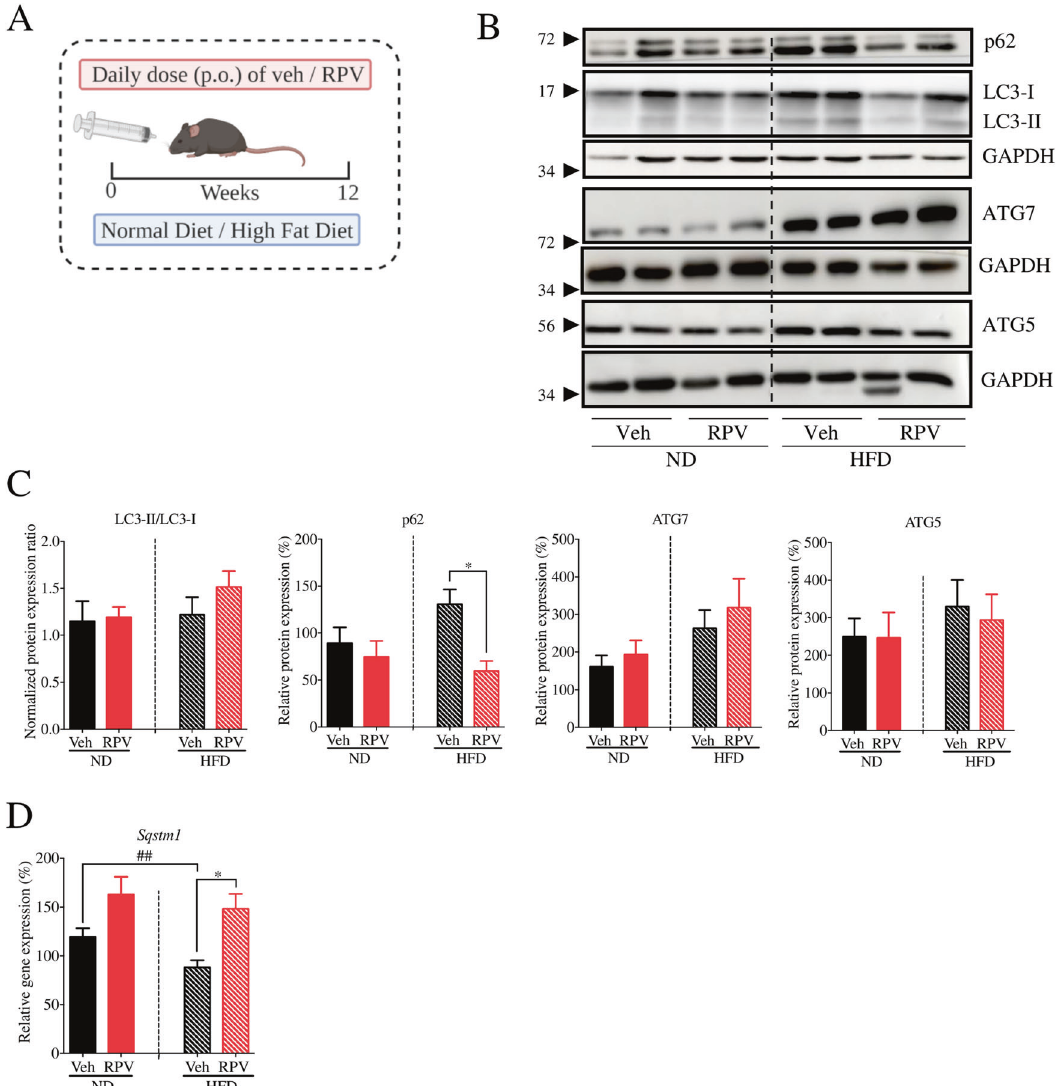
Fig. 1 Effect of RPV on hepatic autophagy in a nutritional model of fatty liver disease. A Female C57BL/6 J mice received normal diet (ND) or a high-fat diet (HFD) for 12 weeks, and were orally administered (p.o.) either RPV (5 mg/kg/day) or its vehicle (Veh, DMSO). B Representative WB images of p62, LC3, ATG5 and ATG7 from total liver protein extracts from 2 mice per group. C Ratio of LC3-II/LC3-I levels obtained through densitometric analysis of LC3 signal from WB. Values were normalized to the ratio in the Veh-ND group which was considered 1. Densitometric analysis of p62, ATG5 and ATG7 signal from WB images. Protein expression was normalized with that of GAPDH. D Relative gene expression of Sqstm1 (p62) obtained through RT-qPCR from total liver RNA using Actb (actin) as a housekeeping gene. Protein and mRNA levels in the Veh- ND group were considered 100%. Data represented as mean ± SEM ( n = 8) were statistically analysed by Student´s t test of RPV treatment vs Veh (* represents p value < 0.05) and HFD vs ND ( ## represents p value <